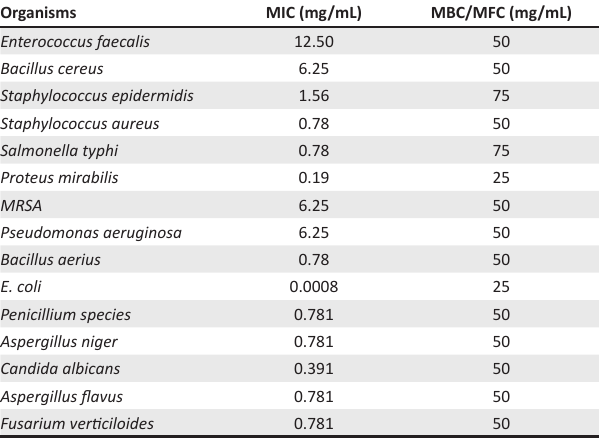
TABLE 4: Minimum inhibitory concentrations and minimum bactericidal/ fungicidal concentrations of the dichloromethane extract against different bacterial and fungal.